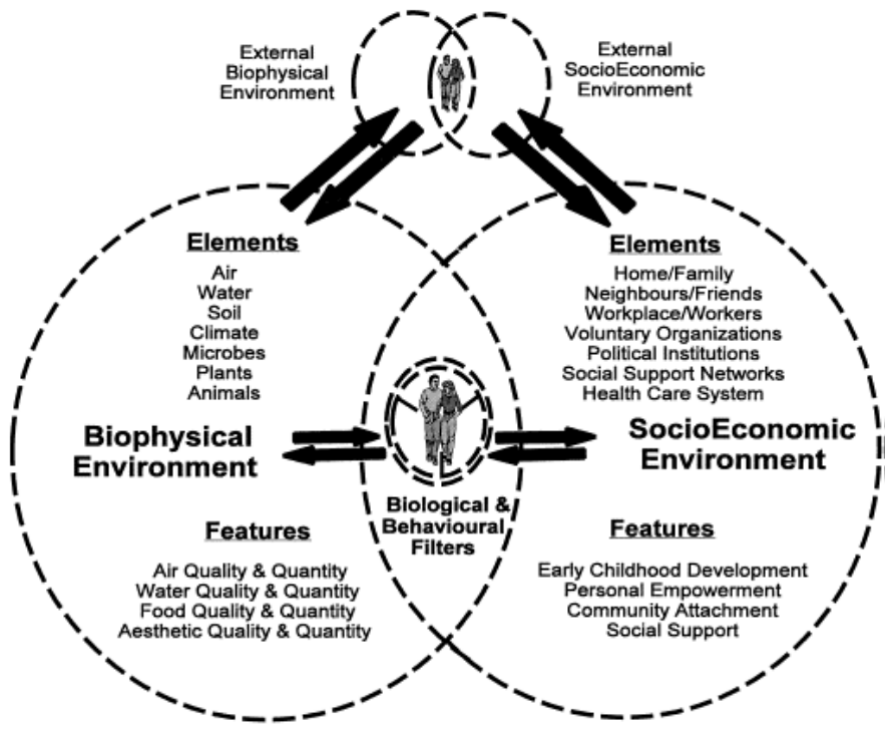
Figure 3. Butterfly Model of Health for an Ecosystem Context